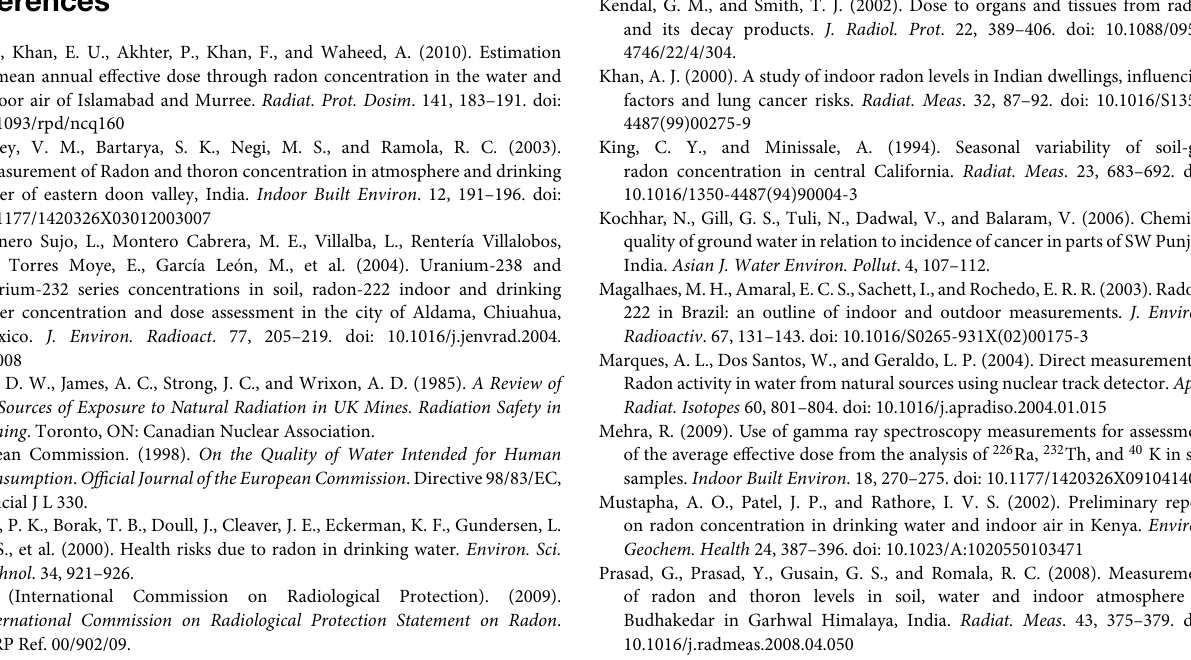
222 Rn concentration in soil is lower than the values reported in USA, Islamabad region of Pakistan and almost equivalent to china as given in Table 2. Using student’s t–distribution with 95% confidence limit as shown in Equation